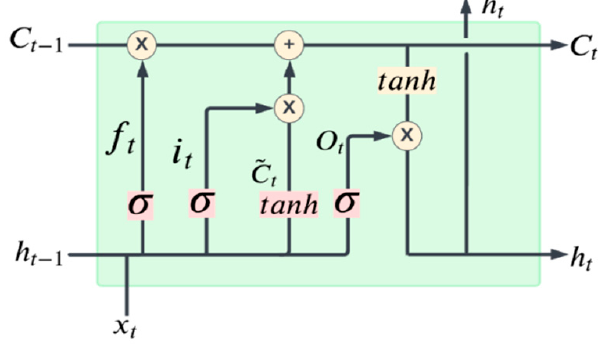
Figure 6. Structure of our LSTM cell at time t .